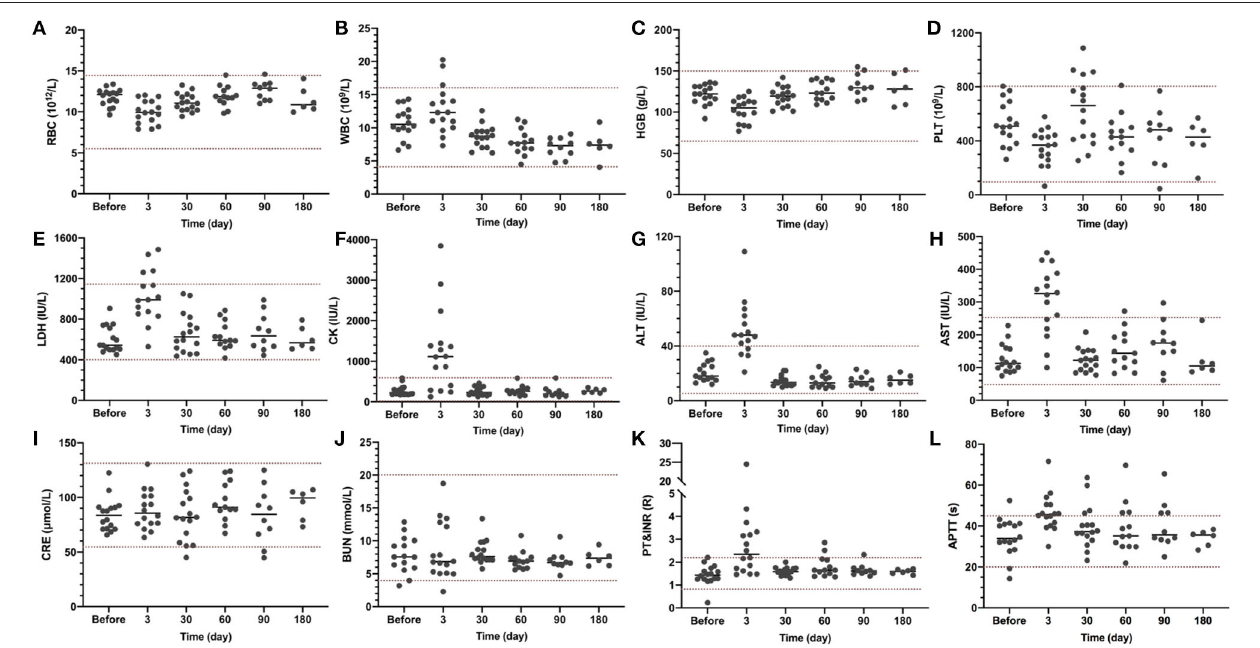
FIGURE 2 | Blood test results at indicated time points. Blood routine, myocardial zymogram, liver function, kidney function, and coagulation were examined. The normal range is indicated between the two dash lines. (A) RBC, red blood cell count; (B) . WBC, white blood cell count; (C) HGB, hemoglobin; (D) PLT, platelet; (E)